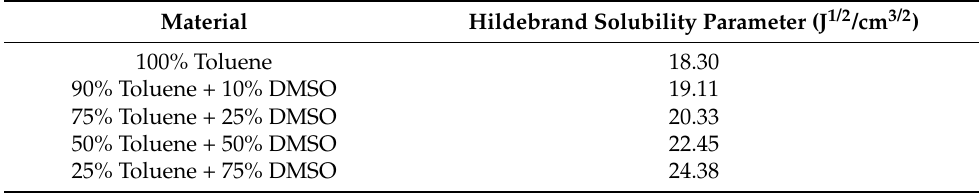
Table 1. Hildebrand solubility parameter of the porogen.